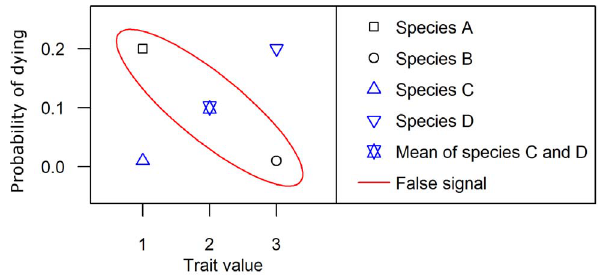
Figure 1. The use of mean traits may produce false signals. Trees of species A and B are botanically well-determined. Trees of species C and D are not, but share the same vernacular name. Using a standard ‘mean-trait’ approach, the mean trait value will be associated with individuals of species C and D, and a false signal may be detected.